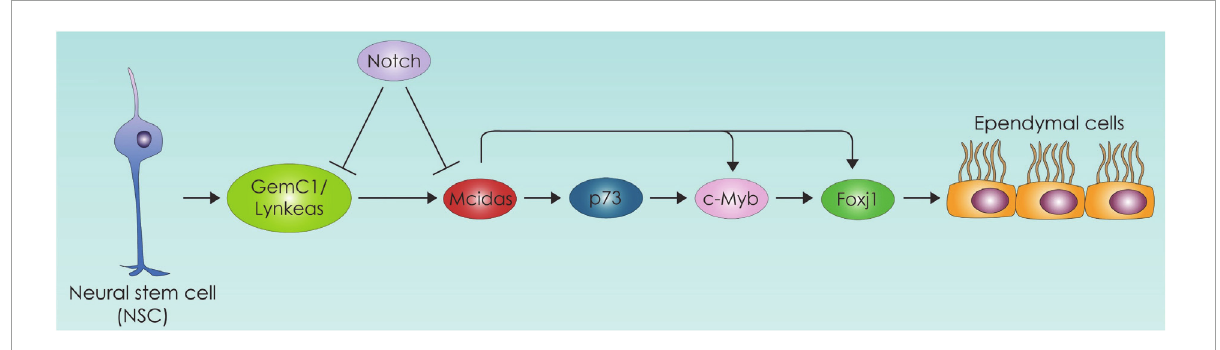
FIGURE4 Neural stem cell differentiation toward the ependymal cell lineage pathway. The ependymal cell differentiation process is depicted which is primarily controlled by the Geminin family protein members. GemC1:Geminin coiled-coil domain-containing protein 1, Mcidas: Multiciliate Differentiation and DNA Synthesis Associated Cell Cycle Protein, Foxj1: Forkhead Box